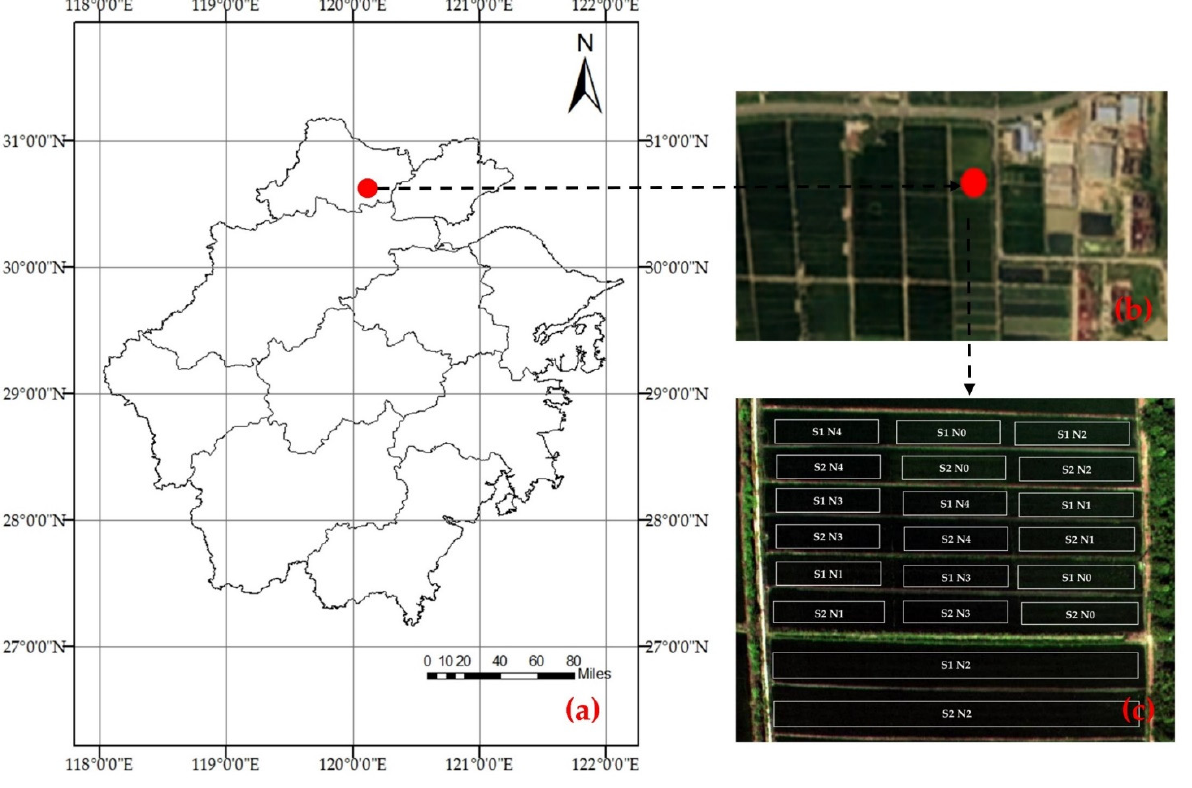
Figure 1. Field experiments. ( a ) Geographical location, ( b ) remote-sensing image, ( c ) experimental plots.